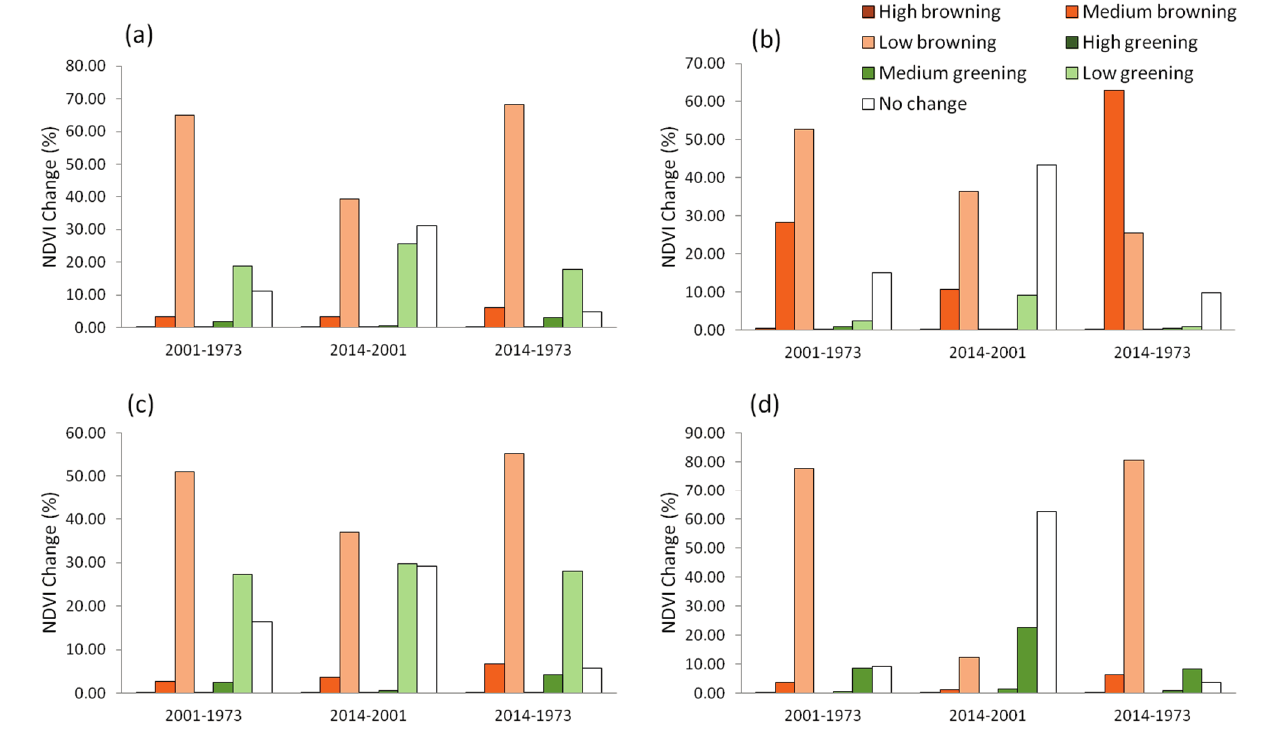
Figure 3. Percent change in NDVI with respect to browning and greening over the four decades across the Biligiri Rangaswamy Temple Tiger Reserve (BRT) landscape (( a ) entire landscape, ( b ) corridors, ( c ) forest within BRT and ( d ) forests outside